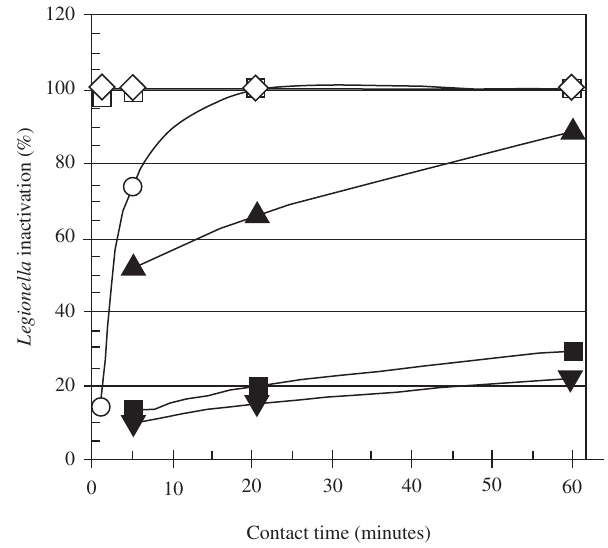
Figure 4. Legionella inactivation vs. contact time after injection, oxidant concentration immediately after Legionella injection and type of water; ( ◊ ) 0.71 ppm oxidant as Cl (tap + NaCl—50 mA.cm –2 ), ( □ ) 0.67 ppm oxidant as 2